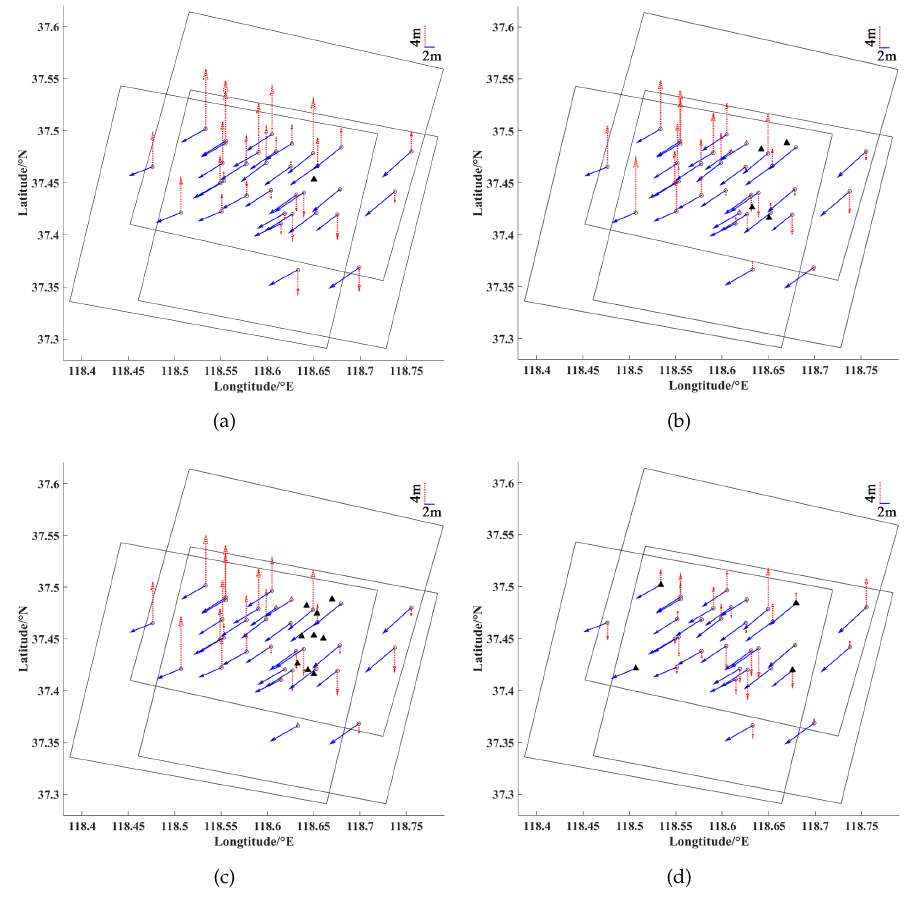
Figure 10. Geometric accuracy analysis of GF2 and GLAS combined geopositioning: ( a ) with one GLAS footprint, ( b ) with four GLAS footprints, ( c ) with nine GLAS footprints and ( d ) with four height control points. The GLAS footprints and height control points are represented as triangles. The plane error and altitude error are represented by the vectors marked with the solid line and the dotted line,